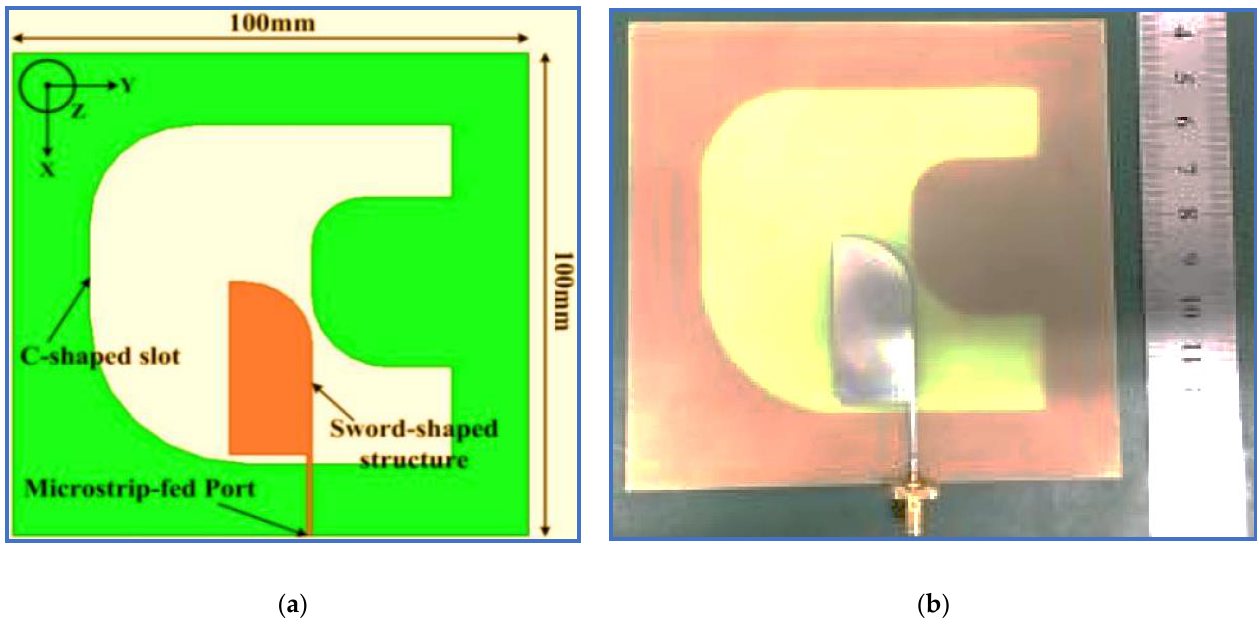
Figure 11. Geometry of a C-shaped slot antenna: ( a ) the dimensions of the proposed antenna and ( b ) the fabricated design [11].